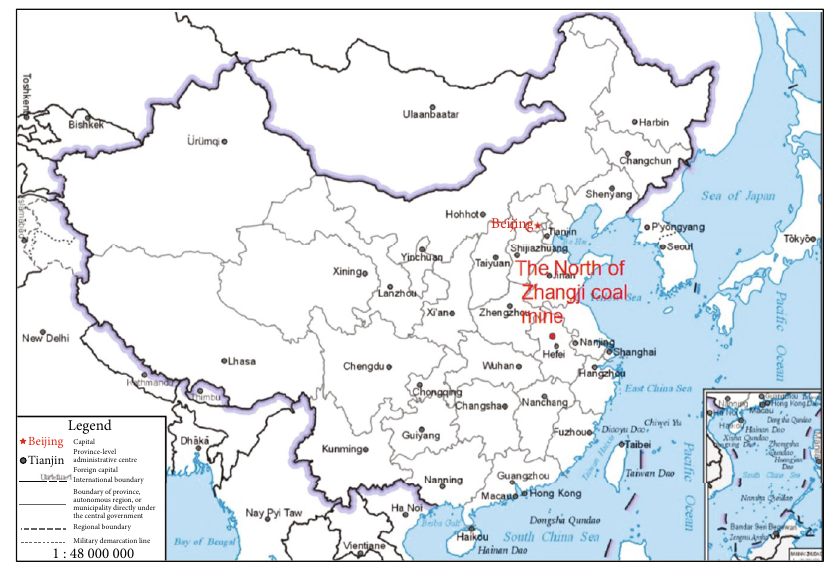
Figure 1: Location of the north of Zhangji coal mine.